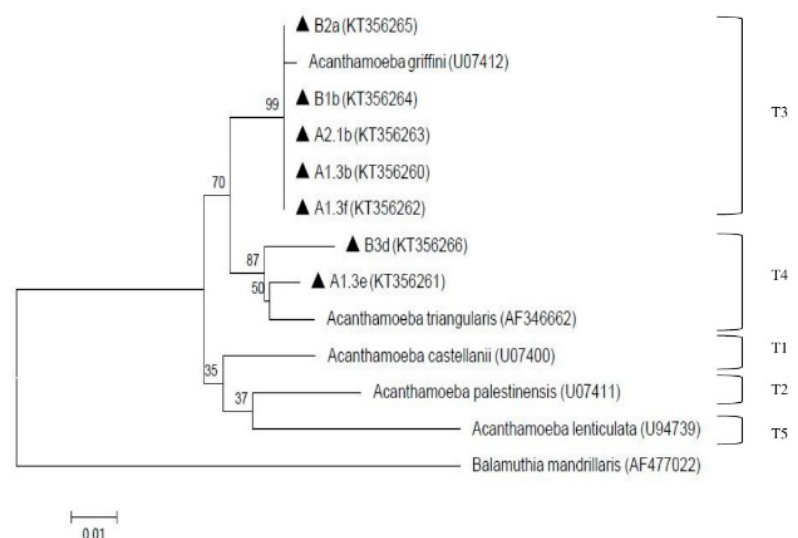
Figure 3. Neighbor-joining tree depicting the relationships between isolates and reference strains representing the genotypes of Acanthamoeba . The numbers on branch points depict the values of 1000 bootstrap replicates. GenBank accession numbers for reference sequences are indicated at the end of the species designations.